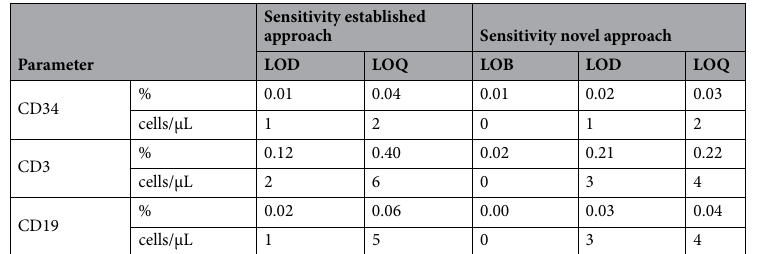
Table 3. Sensitivity results summary for of the Limit of Detection (LOD) and Limit of Quantification (LOQ) measured as established approach for frequencies and absolute counts of the parameters CD34, CD3 and CD19. The novel approach of sensitivity measurements estimates additionally the Limit of Blank (LOB) by Armbruster et al. 13 .